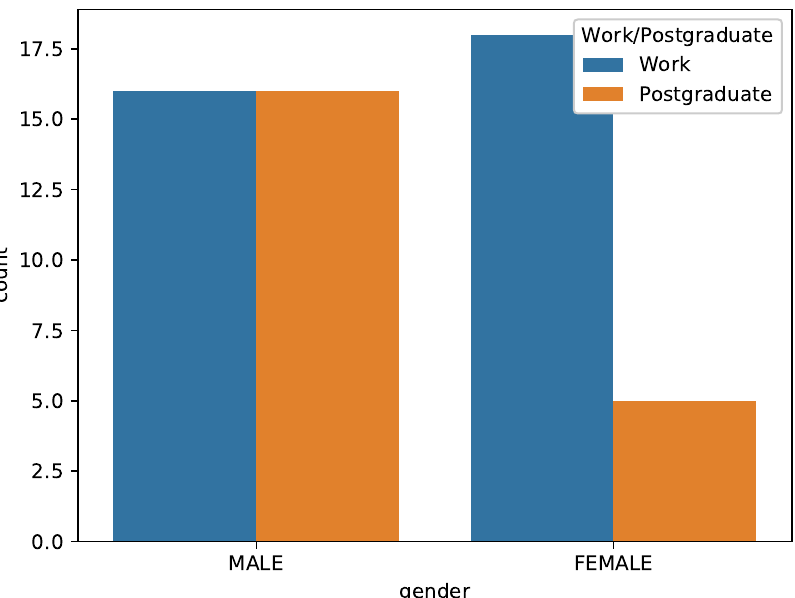
Figure 7. The relationship between gender and the proportion of graduate career choices.